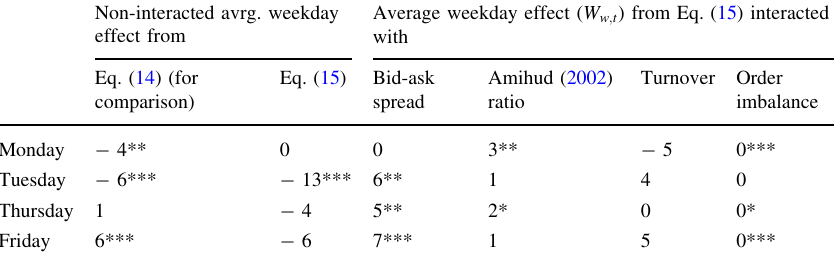
Table 7 Effects of liquidity and order imbalance on returns, part 4: Weekday effect Non-interacted avrg. weekday effect from